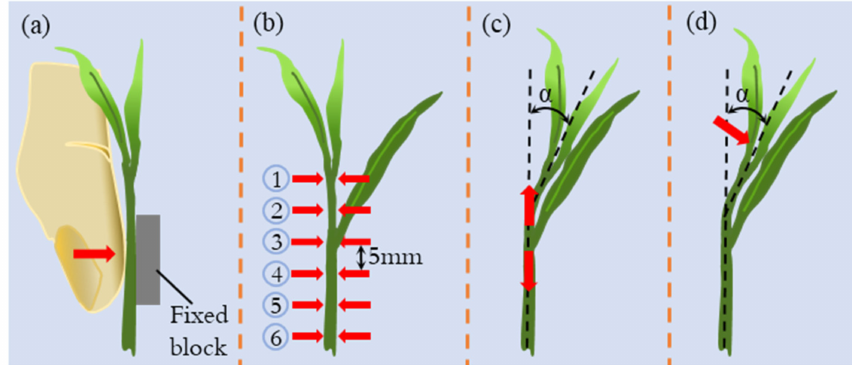
Figure 4. Loading modes used for the analysis of mechanical properties. ( a ) Flexible clamping force. ( b ) Damage forces in different locations. ( c ) Pull-off force. ( d ) Bending force. α is the stalk bending angle.